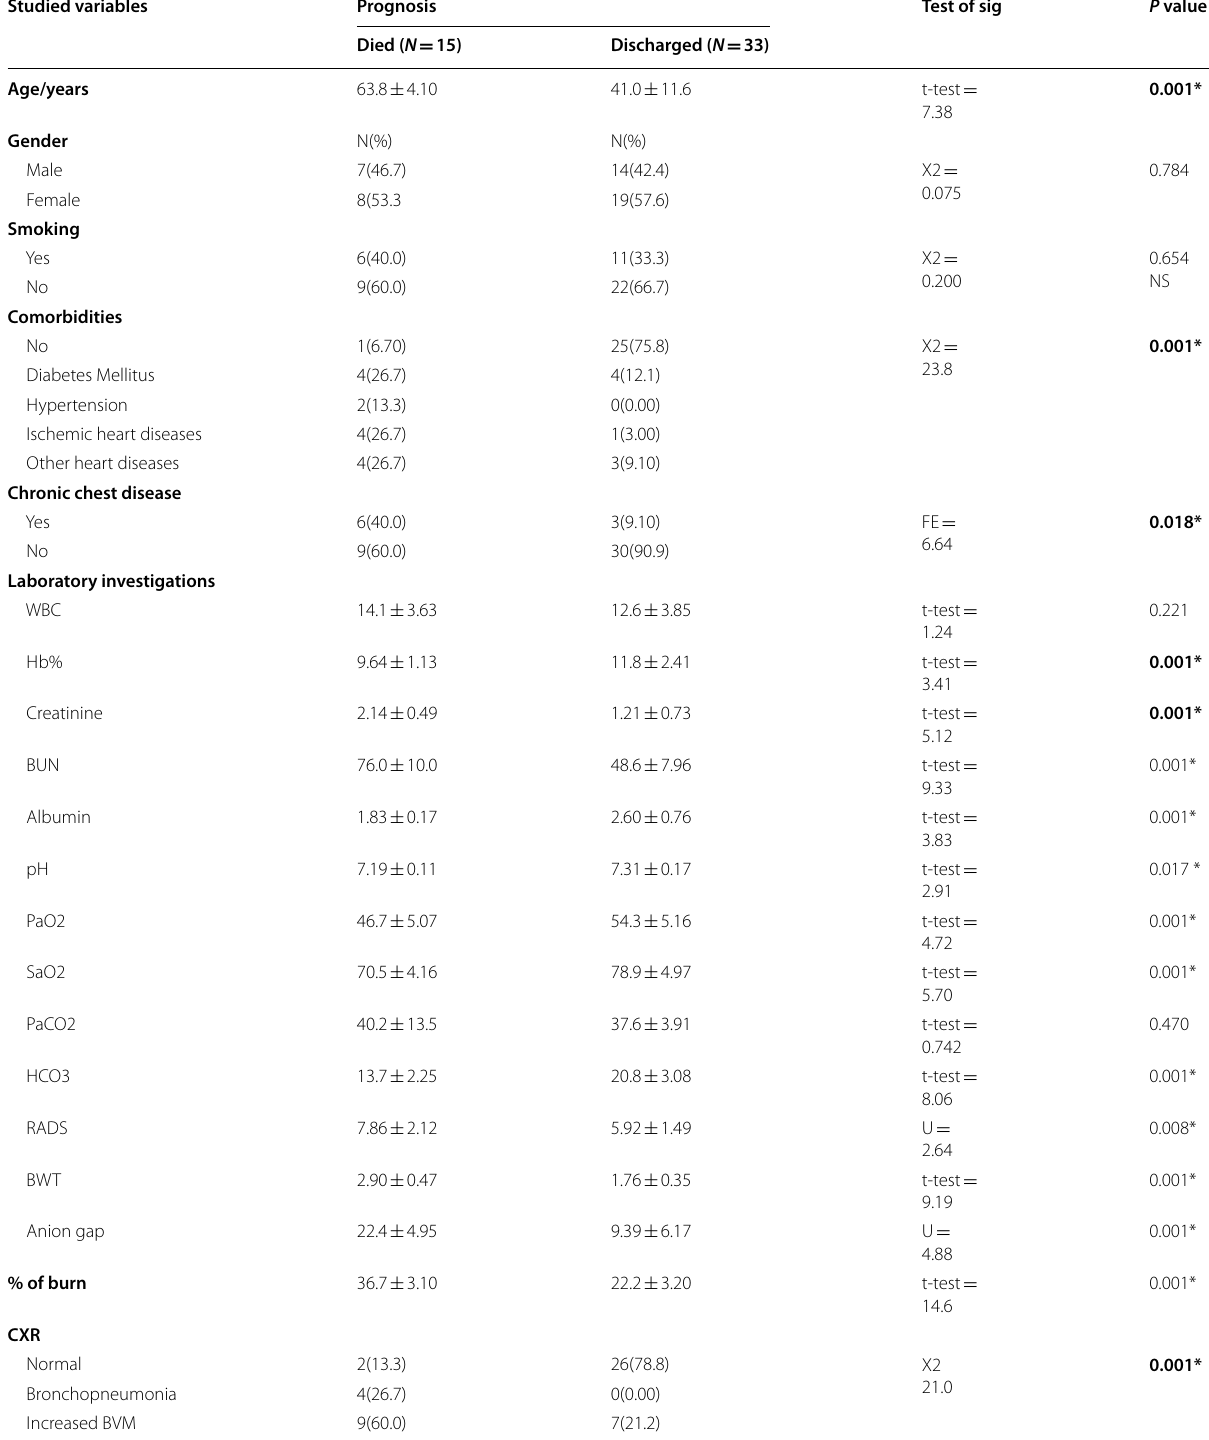
Table 6 Relation between patient prognosis and different parameters in inhalation lung injury